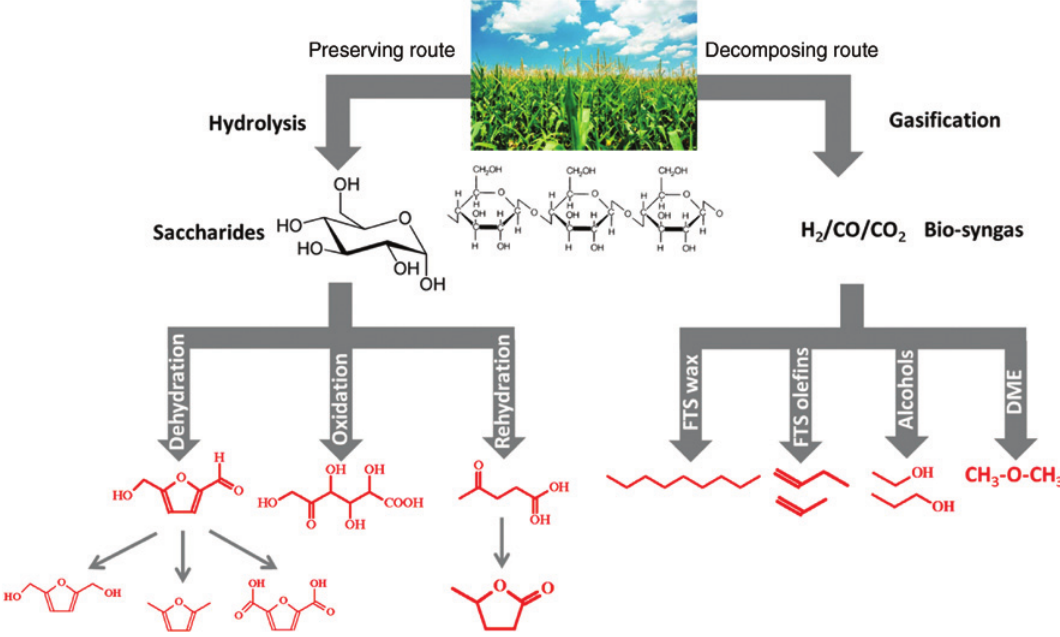
Figure 1: Scheme of biomass